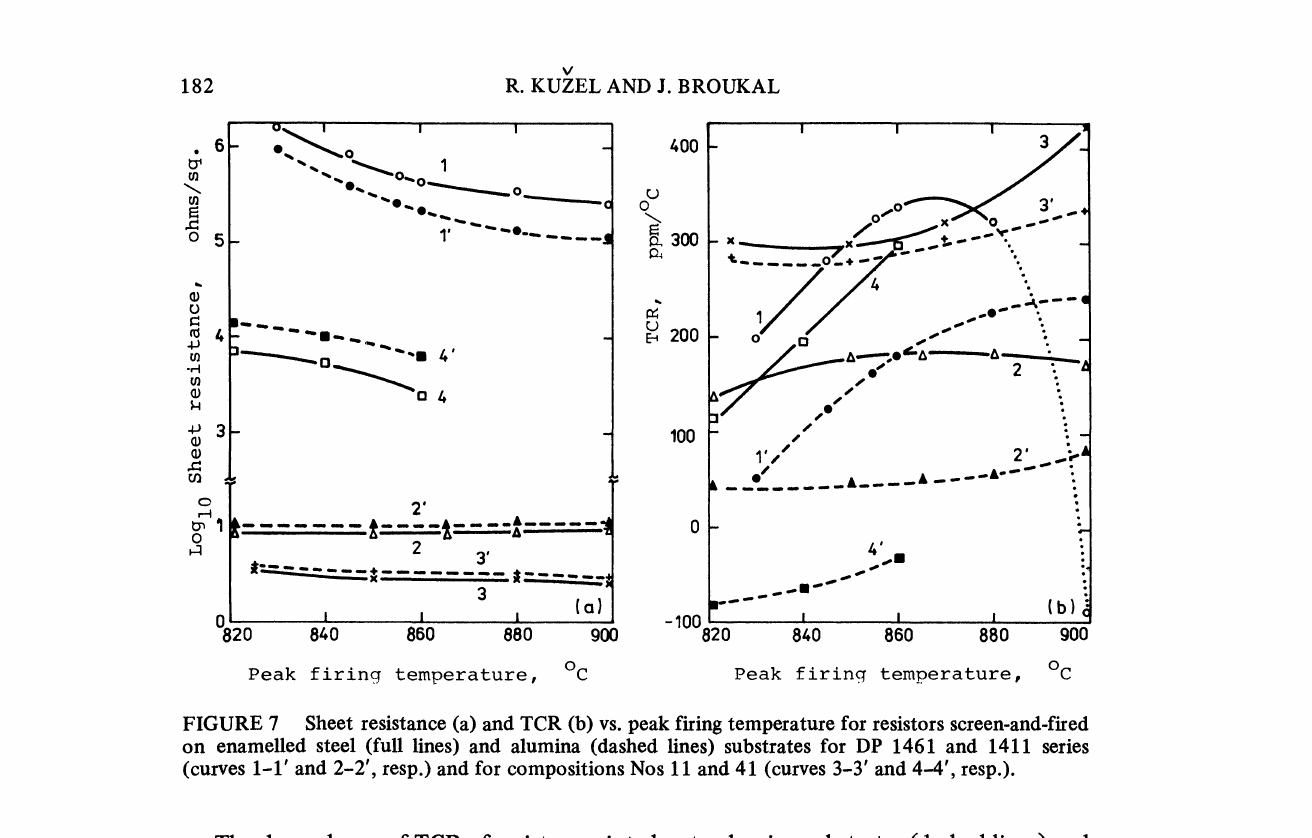
FIGURE 7 Sheet resistance (a) and TCR (b) vs. peak firing temperature for resistors screen-and-fired on enamelled steel (full lines) and alumina (dashed lines) substrates for DP 1461 and 1411 series (curves 1-1’ and 2-2’, resp.) and for compositions Nos 11 and 41 (curves 3-3’ and 4-4’,